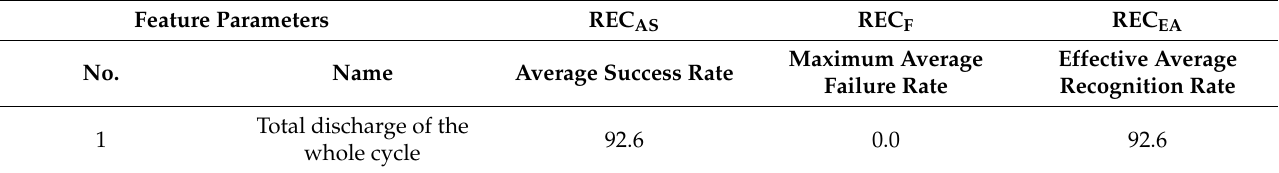
Figure 30. GIS-1 partial discharge feature: basic discharge parameter recognition rate. Table 7. GIS-1 better recognition rate of characteristic parameters: basic discharge